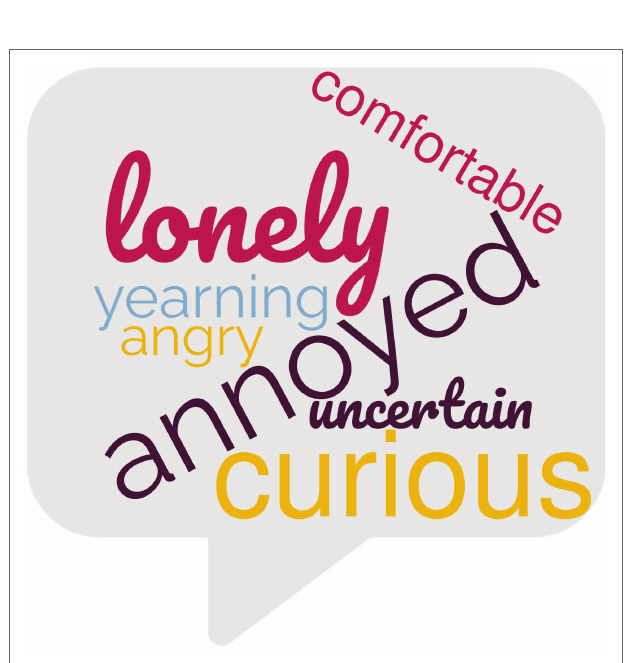
FIGURE 3 | Wordcloud graphic depicting emotion themes most likely to be associated with built